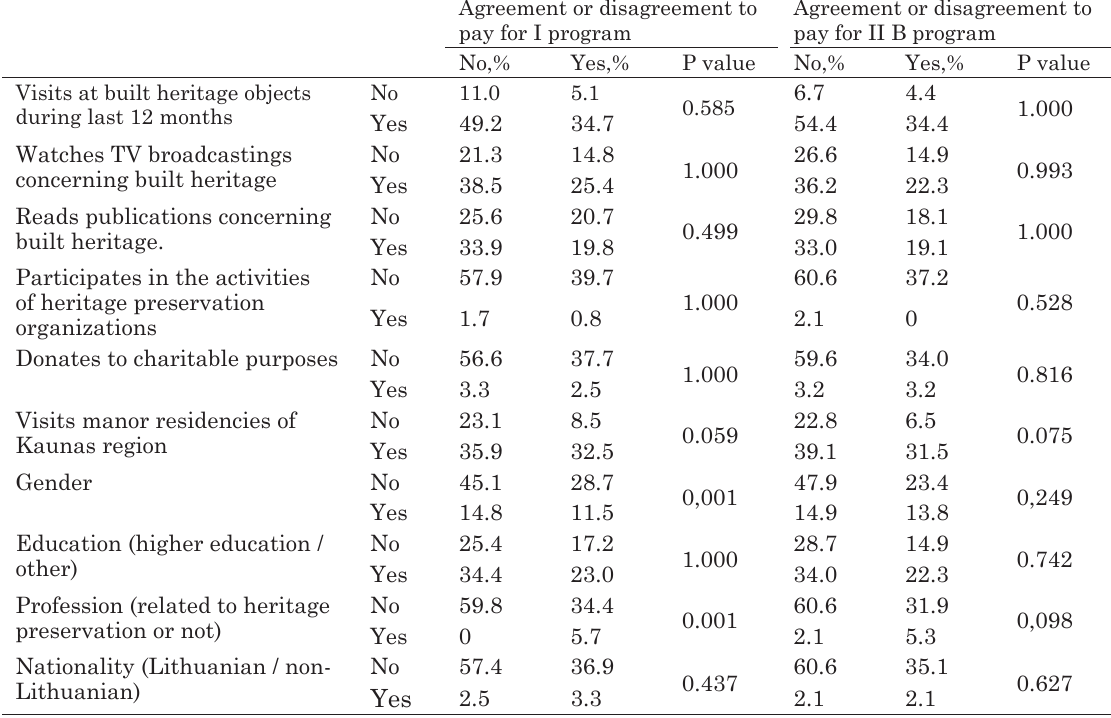
table 2. response percentages and results of test for